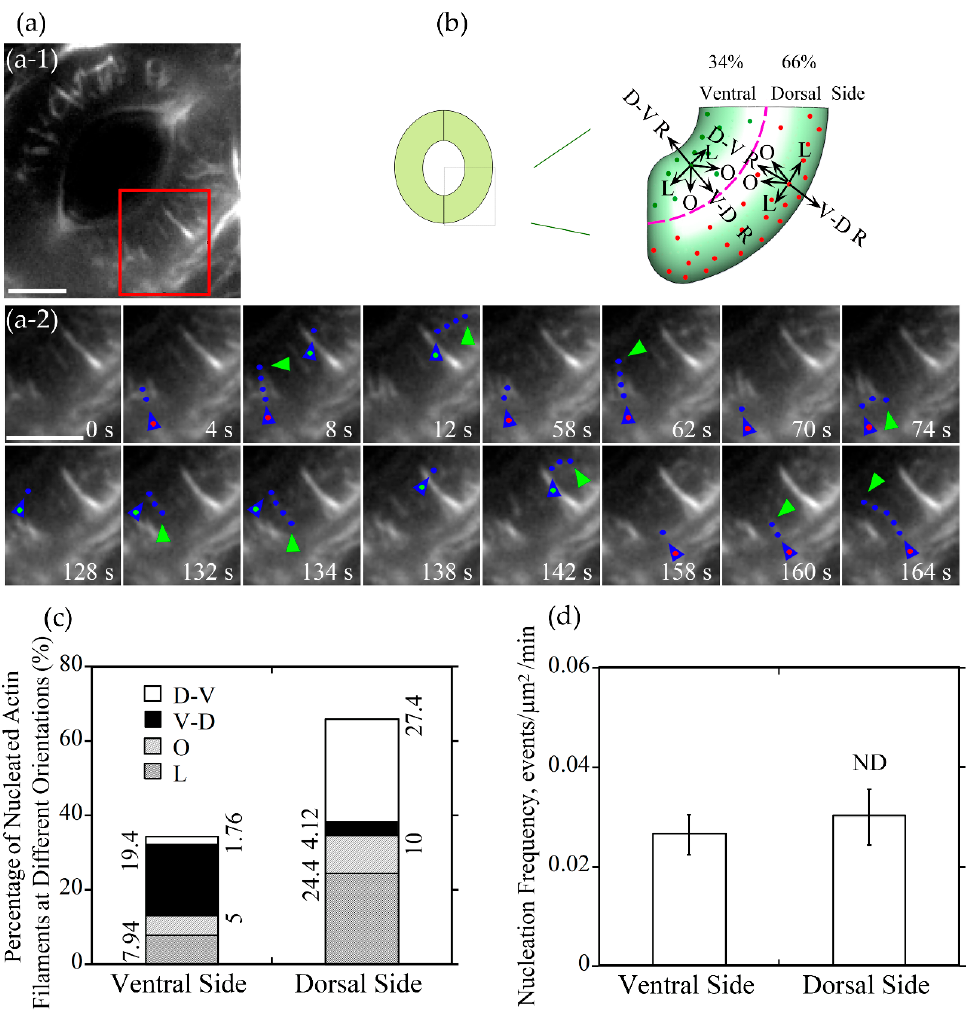
Figure 3. Actin nucleation occurs at both dorsal and ventral sides and actin filaments elongate mainly in radial orientation in guard cells of open stomata. ( a ) Dynamics of actin nucleation and elongation of single actin filaments in guard cell of open stomata in wild-type (WT). ( a - 1 ) Overview of the open stomata expressing GFP-ABD2-GFP, the red box marked the region of interest. ( a - 2 ) An enlarged view of time-lapse images of actin nucleation and elongating direction in the region of interest in ( a - 1 ). Blue triangles with red dot inside indicate the nucleation sites or the starting points of the elongating actin filaments in the dorsal side of guard cells, and blue triangles with green dot inside indicate the nucleation sites or the starting points of the elongating actin filaments in the ventral side of guard cells. Blue dots indicate the elongating actin filaments. Green triangles indicate the newly elongated direction of actin filaments. Bar = 5 μ m. ( b ) Schematic diagram describing actin filaments of four different orientations (D-V R, dorsal-to-ventral radial; V-D R, ventral-to-dorsal radial; O, oblique; L, longitudinal) in dorsal and ventral side of guard cells in open stomata. The dotted pink line is the boundary between dorsal and ventral region of the guard cell. Red and green dots represent actin nucleation sites in dorsal and ventral region of the guard cell, respectively. Arrows indicate the direction of the elongation of the actin filaments. ( c ) The proportion of actin filaments at each orientation (D-V R, dorsal-to-ventral radial; V-D R, ventral-to-dorsal radial; O, oblique; L, longitudinal) in the dorsal side and ventral side of guard cells in open stomata. ( d ) Quantification of actin nucleation frequency. Actin nucleation frequency was defined as number of actin nucleation events per unit area per unit time (events/ μ m 2 /min). ND, no significant difference. See Supplemental Movie 1 online for the entire series in ( a ). Bar = 5 μ m.